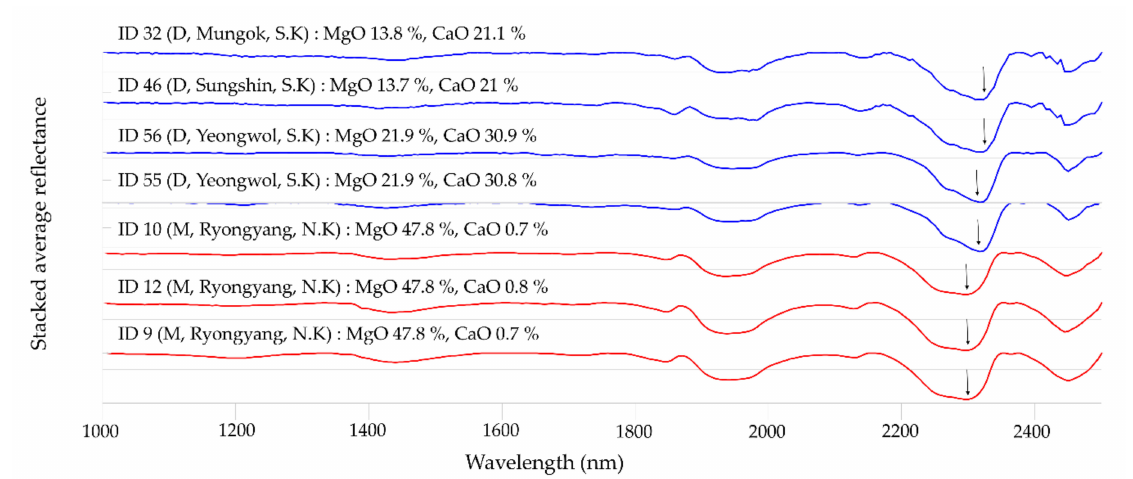
Figure 5. The spectral characteristics of magnesite (red lines) and dolomite samples (blue lines) associated with MgO content.